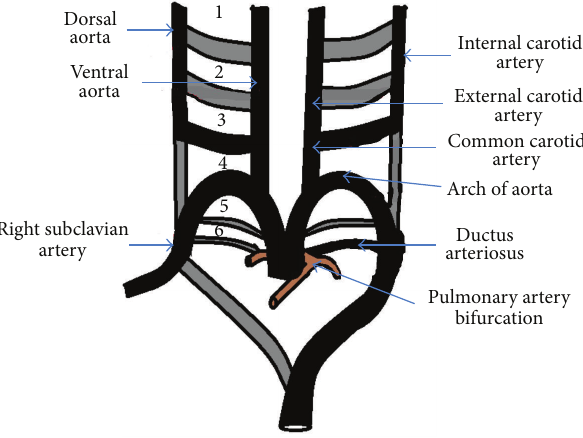
Figure 1: Development of aortic arches is depicted. Numbers one to six represent the aortic